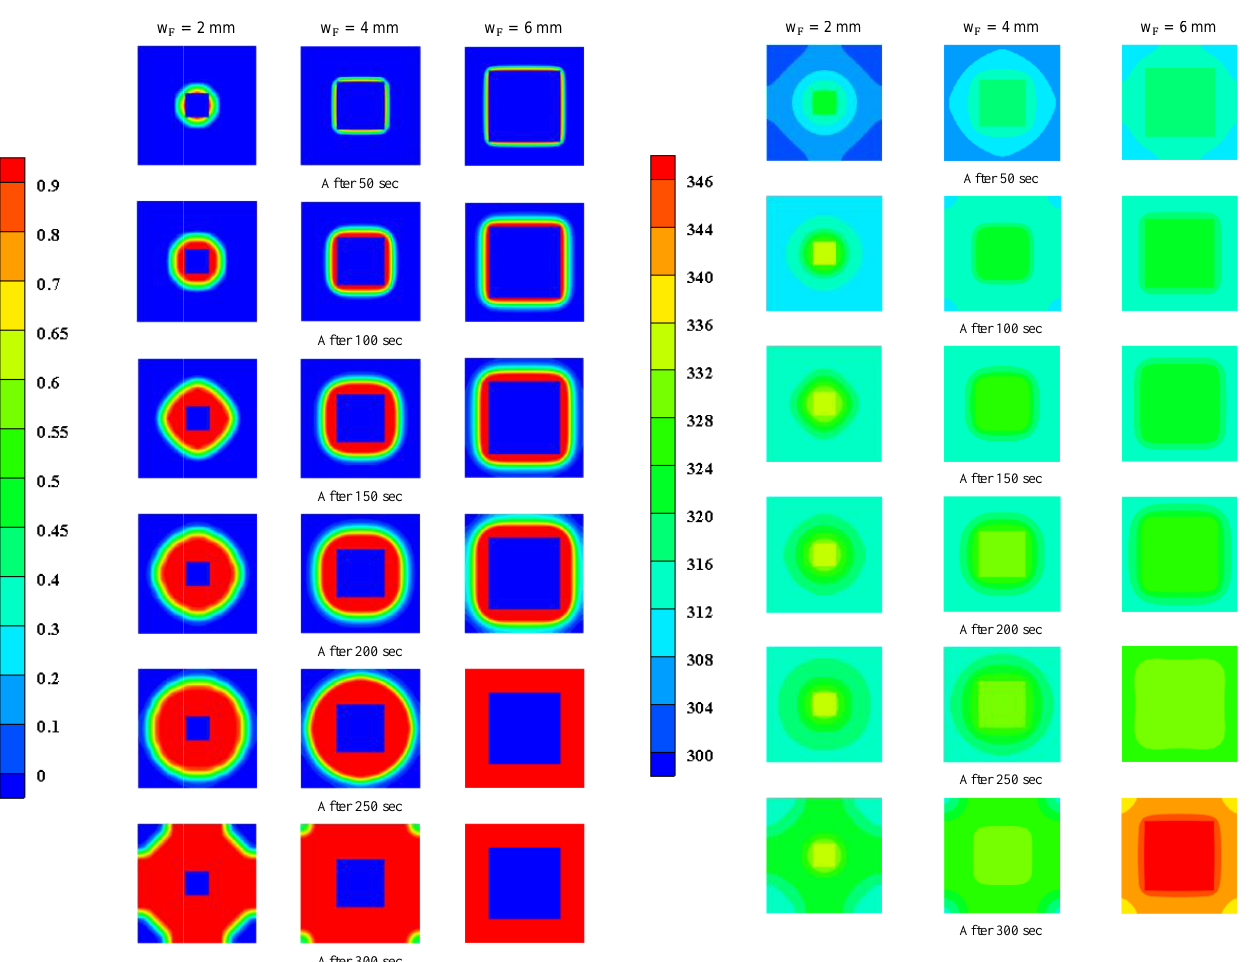
Figure 9. Temperature evolution for 49 fins and various fin thick-